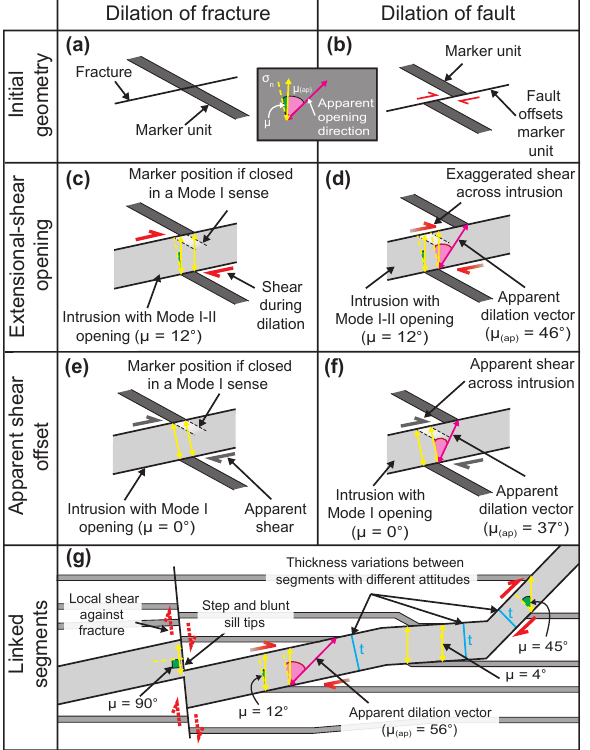
Figure 2. Schematic diagrams to show the relationship between opening mode and apparent shear. (a–b) Initial pre-intrusion ge- ometries with a marker unit oblique to the fracture/fault plane. (c– d) Extensional-shear dilation of a pre-existing fracture and fault.